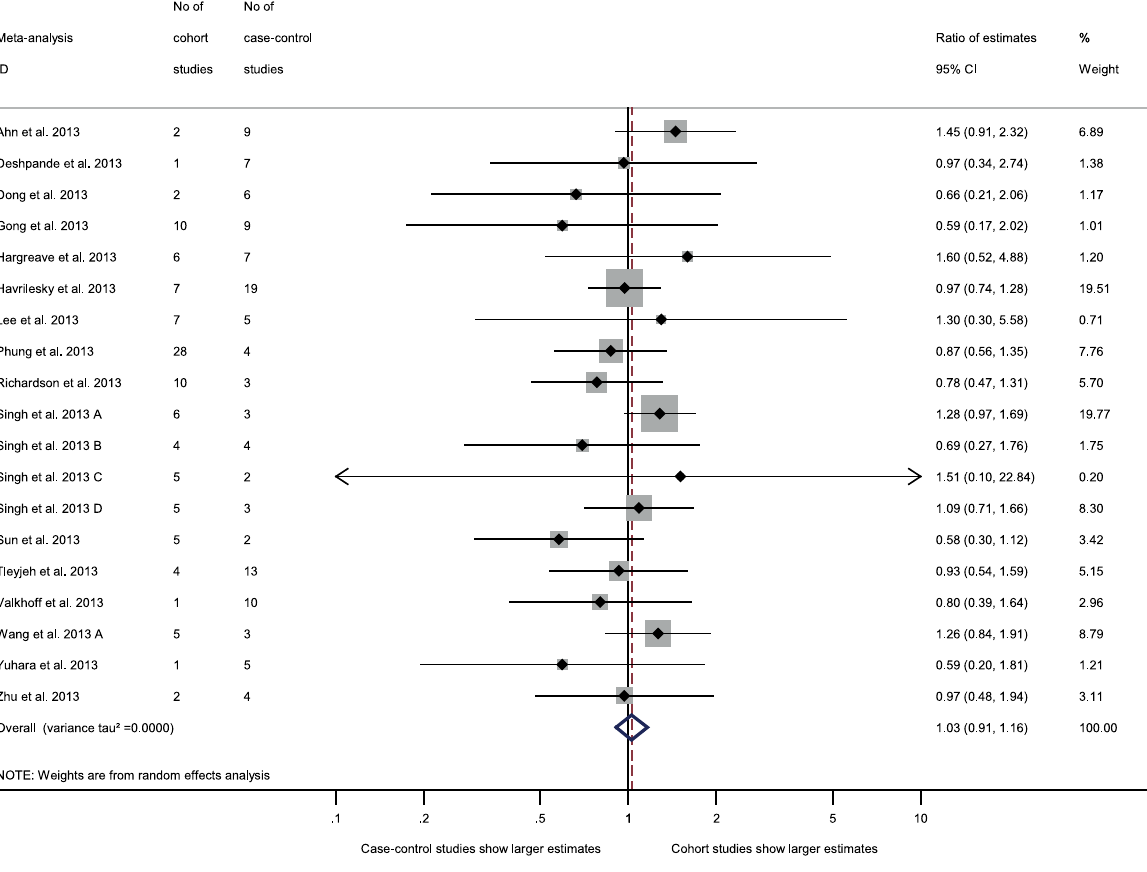
Fig 3. Sensitivity analysis of differences in effect estimates between case – control and cohort studies with available data on adjusted estimates. Difference in treatment effect estimates is expressed as ratio of estimates (RE). A RE < 1 indicates that case – control studies yielded larger estimates of the intervention effect or adverse events than cohort